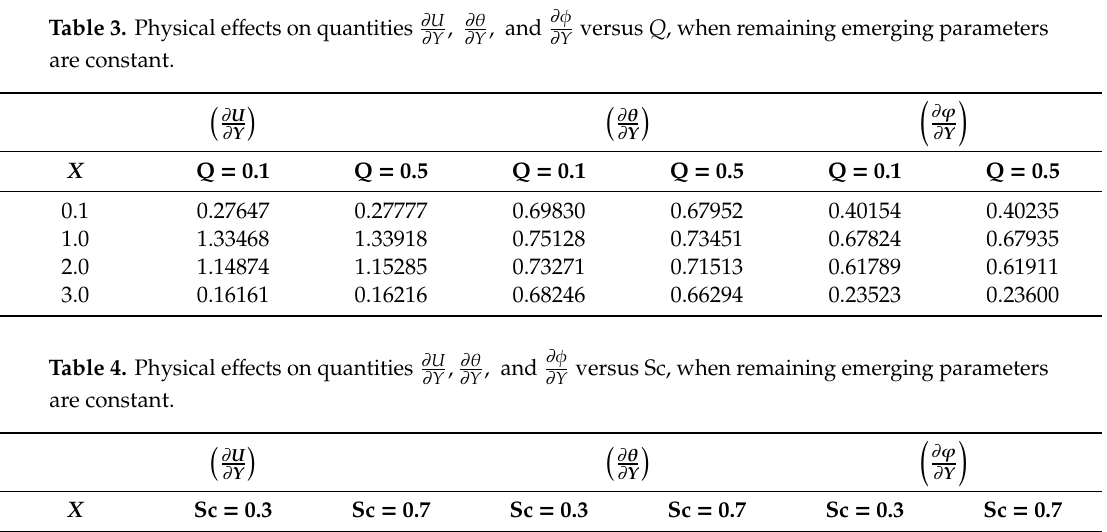
∂φ ∂θ , ∂ Y , and ∂ Y versus Q , when remaining emerging parameters Y